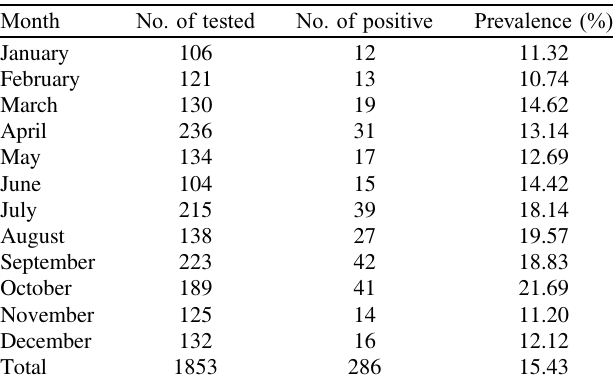
Table 3. Seroprevalence of T. gondii infection in different months by